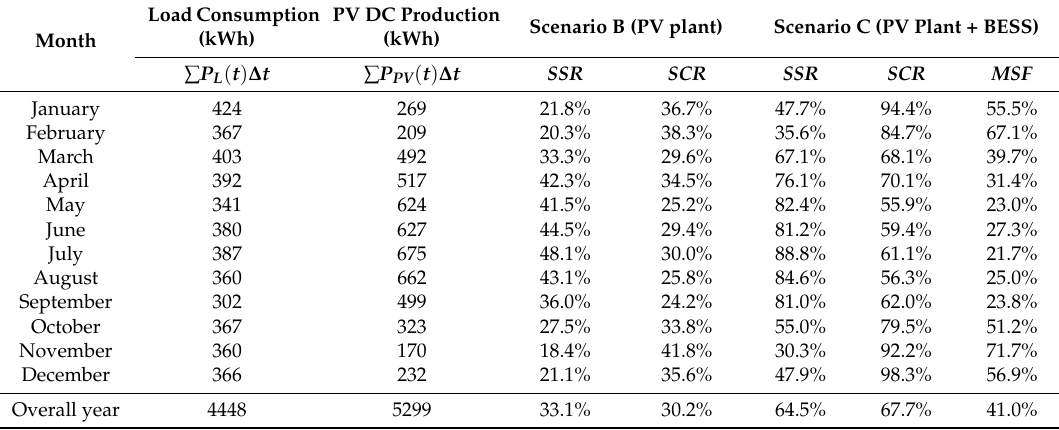
Table 6. Monthly trend of representing parameters SSR , SCR , and MSF in Scenario B and in Scenario C (all of these parameters are dimensionless), related to monthly data of load consumption and PV energy injected in the DC bus.